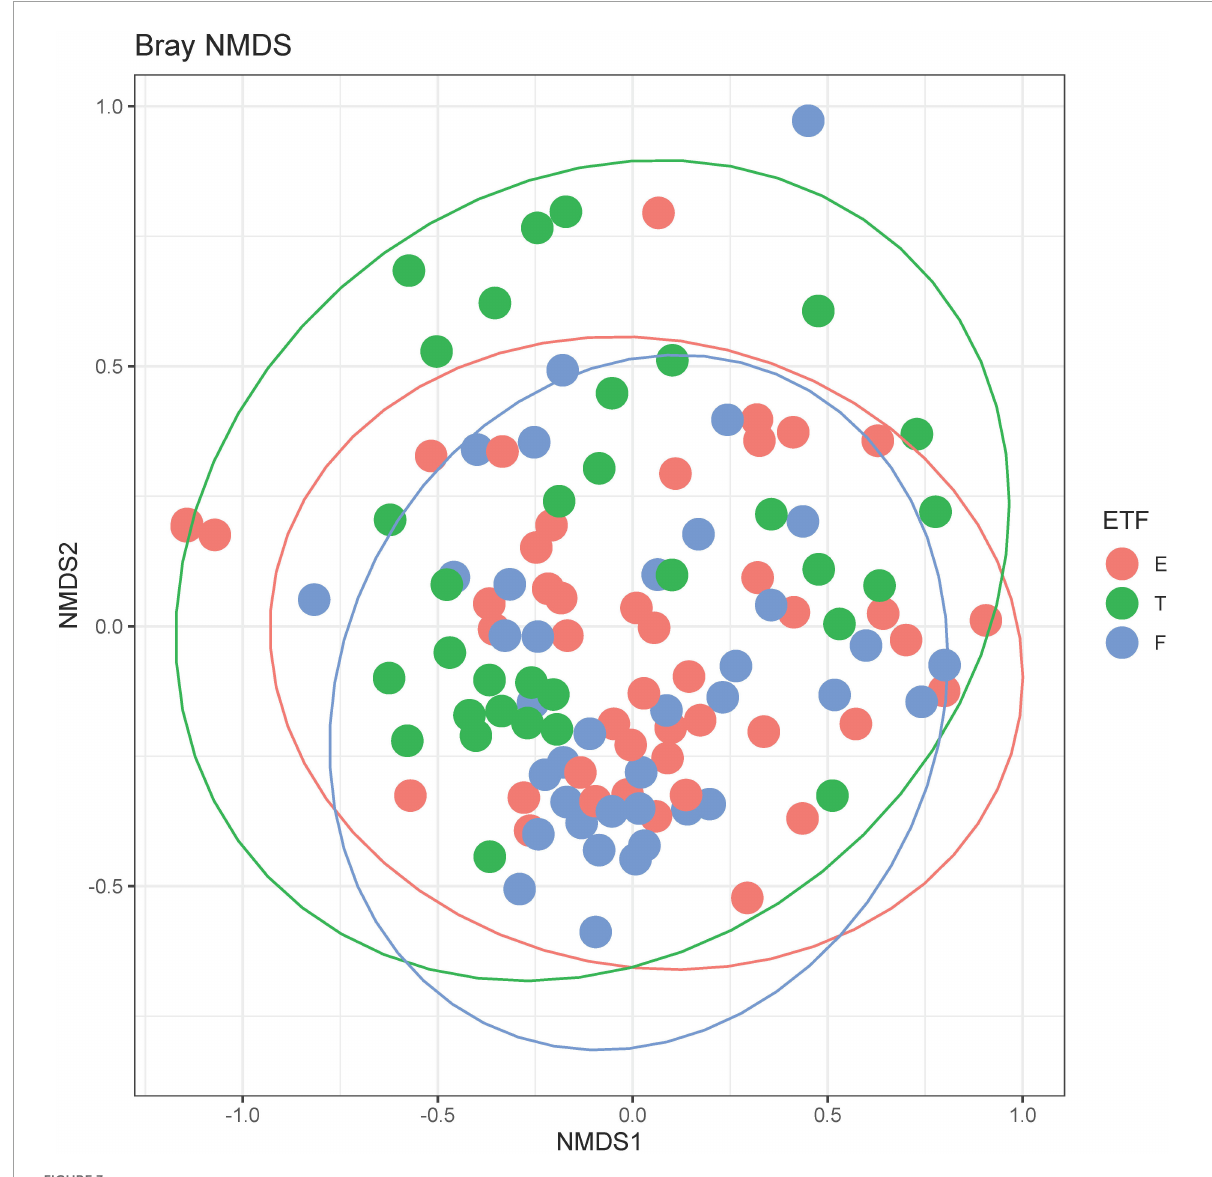
FIGURE3 Bray-Curtis non-metric multidimensional scaling (NMDS) plot. E, pulmonary exacerbation; T, end of treatment; F, follow up. The ellipses represent the t distribution. The adonis test was significant at p = 0.001, controlling for repeated patient samples using the strata function.